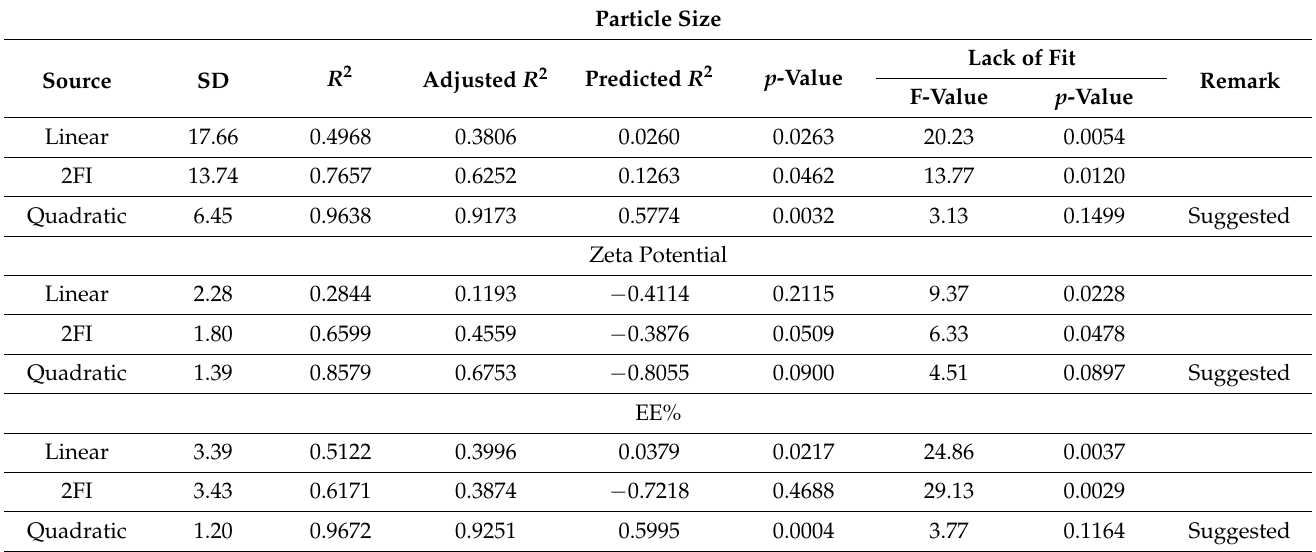
Table 3. Summary of statistical models for the measured responses.